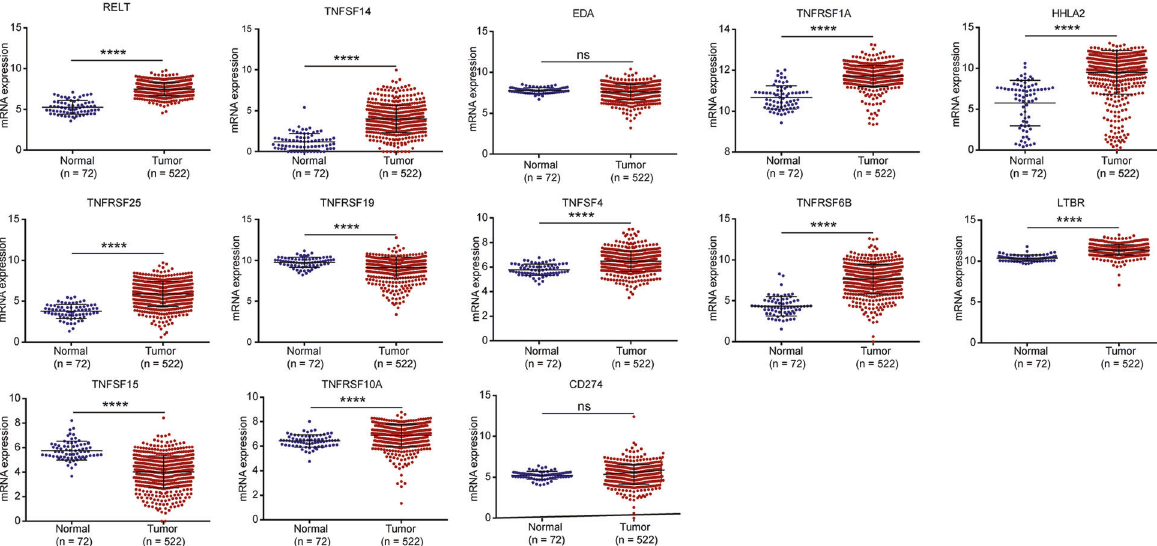
Fig. 4 Differential expression of 13 costimulatory molecule genes between normal and tumor tissues. Genes, including RELT, TNFSF14, TNFRSF1A, HHLA2, TNFRSF25, TNFSF4, TNFRSF6B, LTBR, and TNFRSF10A were high-expressed in tumor tissues compared with normal tissues. TNFRSF19 and TNFSF15 were low-expressed in tumor tissues compared with normal tissues. While EDA and CD274 showed no signi fi cant difference in tumor tissues compared with normal tissues. ns: P > 0.05; * P < 0.05; ** P < 0.01; *** P < 0.001; **** P < 0.0001.